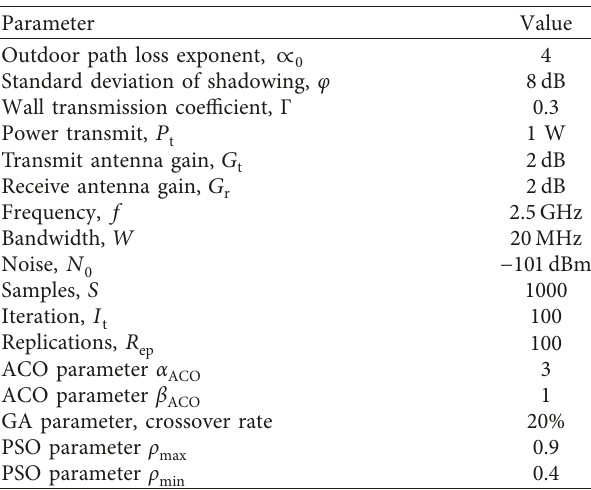
Figure 1: Outdoor model configuration. Table 1: Parameter of